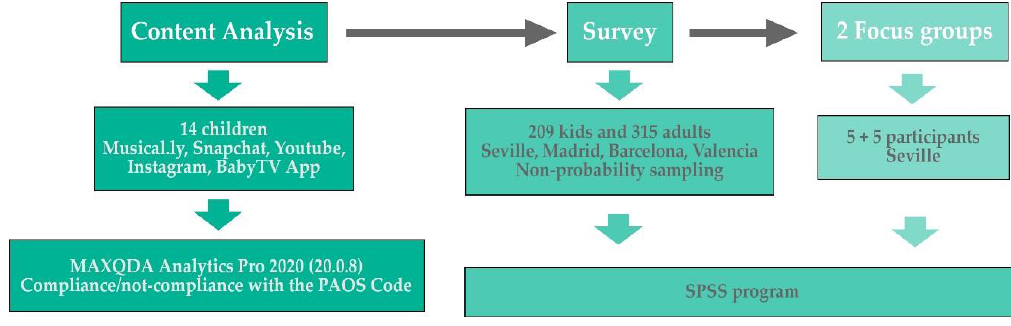
Figure 1. Used methodology.